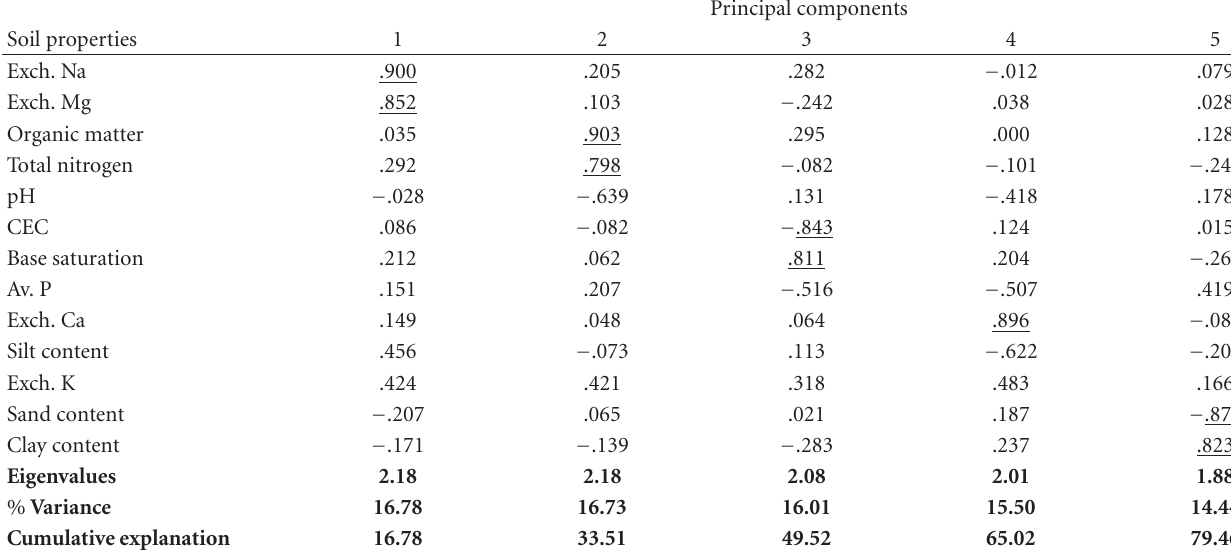
Table 4: Rotated components of soil properties a . Principal